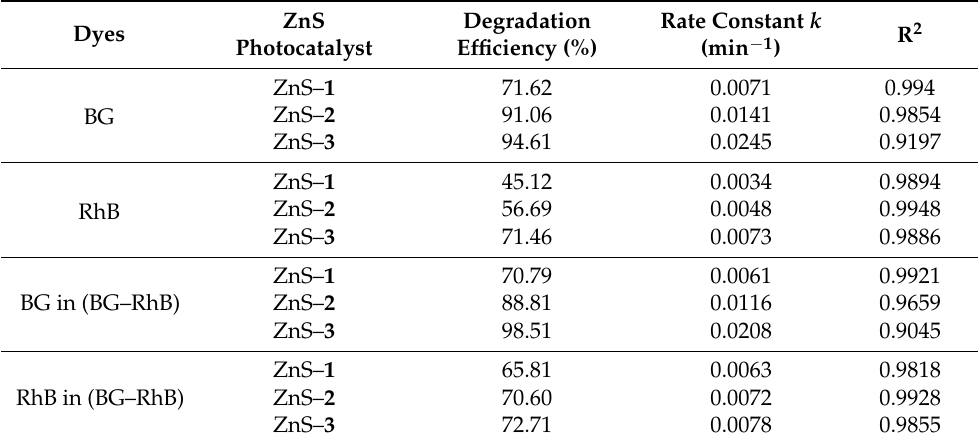
Table 1. The photocatalytic degradation parameters of single and mixed dyes over ZnS quantum dots under visible light